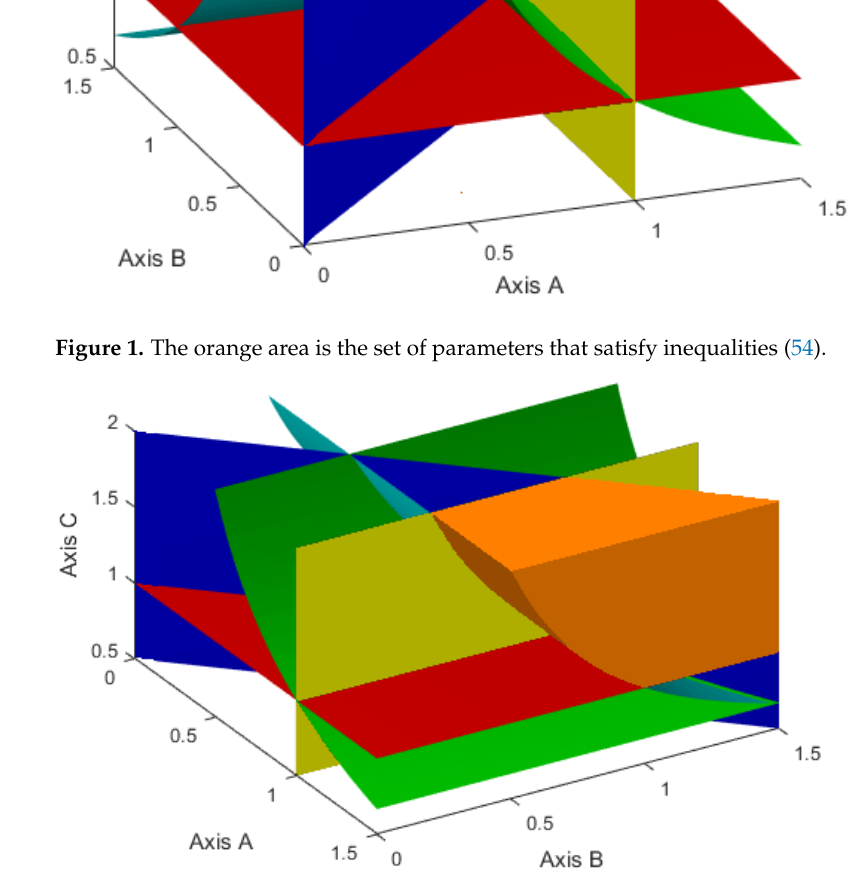
Figure 2. The orange area is the set of parameters that satisfy inequalities